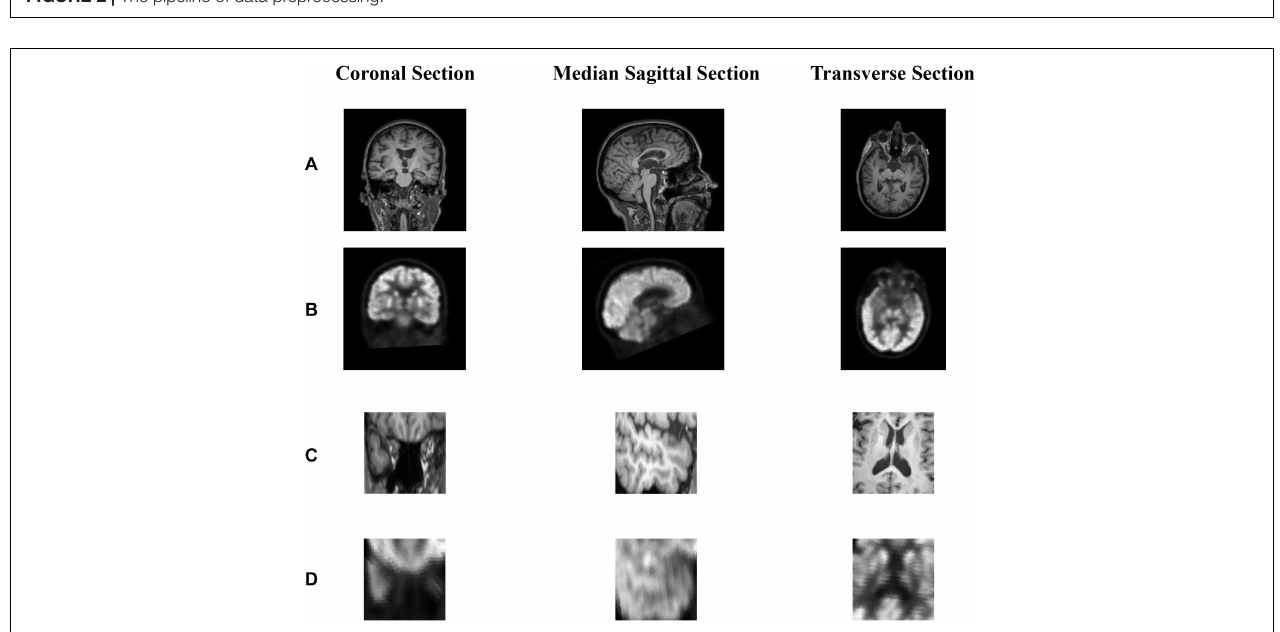
FIGURE 2 | The pipeline of data